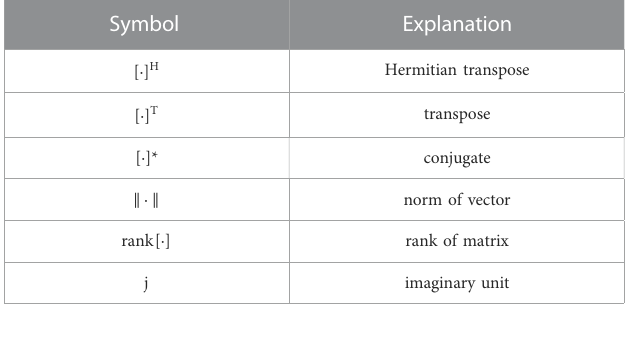
TABLE 1 Common symbols in this